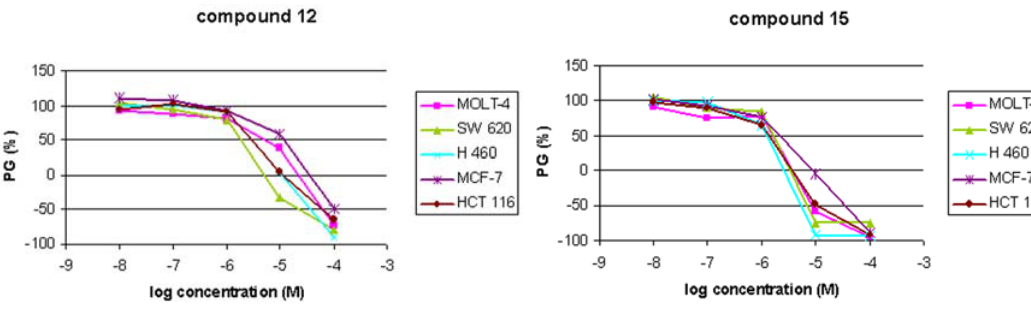
Figure 1. Dose-response profiles for compounds 12 and 15 . PG = percentage of growth.